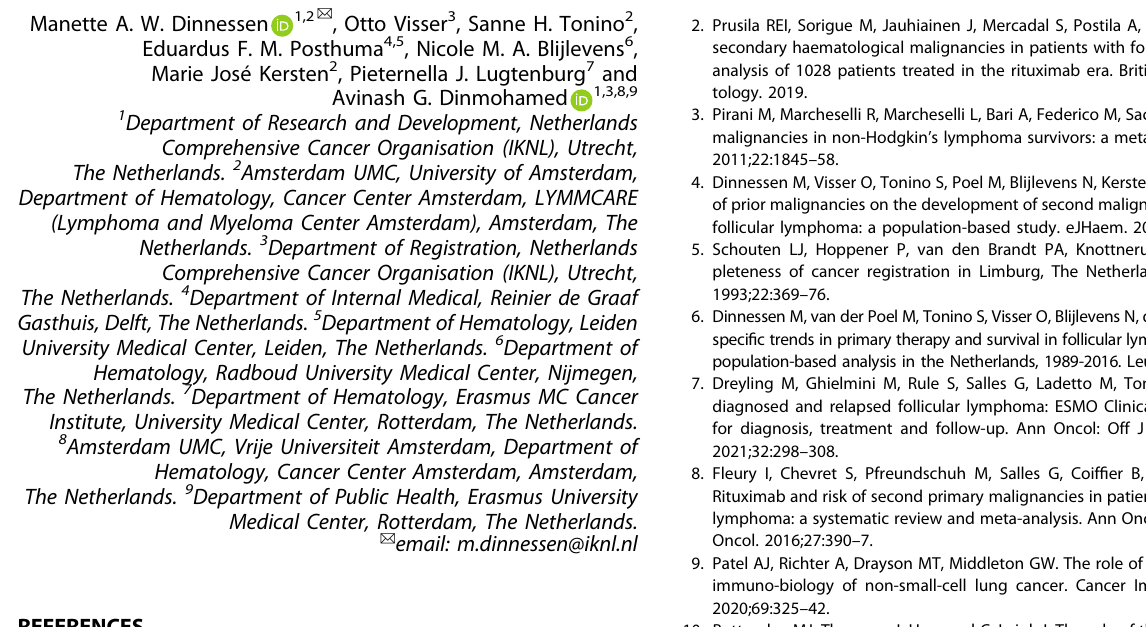
Fig. 1 Risk of second primary malignancies (SPMs) compared to the general population among patients with follicular lymphoma. The tables present the observed number of SPMs (Obs), the standardized incidence ratios (SIRs) with 95% con fi dence intervals (CIs), and the absolute excess risk (AER) per 10 000 person-years. Statistically signi fi cant SIRs are presented in bold in the tables and as solid black boxes in the plots that visualize the SIRs with 95%